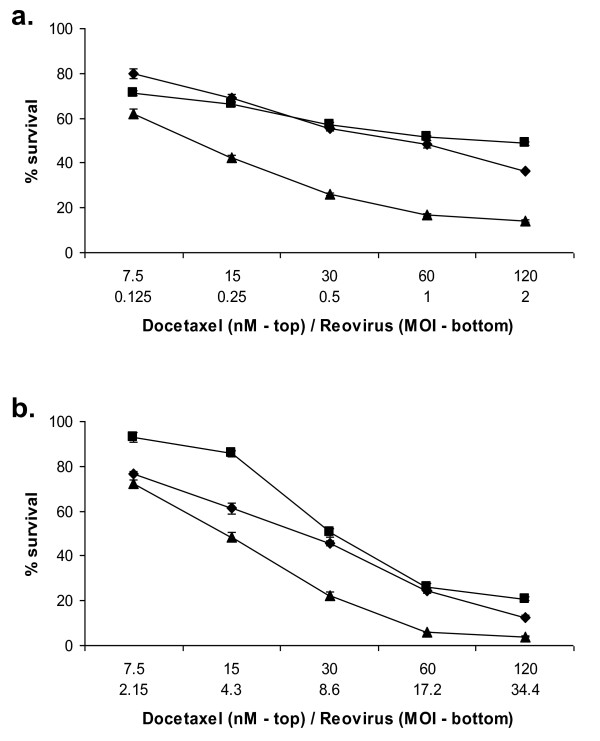
Reovirus induced cell kill is enhanced by the addition of docetaxel. PC3 (a) and Du 145 cells (b) were treated with reovirus alone (diamonds), docetaxel alone (squares) or a combination of the two (triangles) at the doses indicated for 48 h. Survival was measured at this time using MTS. In both cell lines tested, the combined treatment significantly reduced cell survival compared to either treatment alone (2-way ANOVA, p < 0.0001).